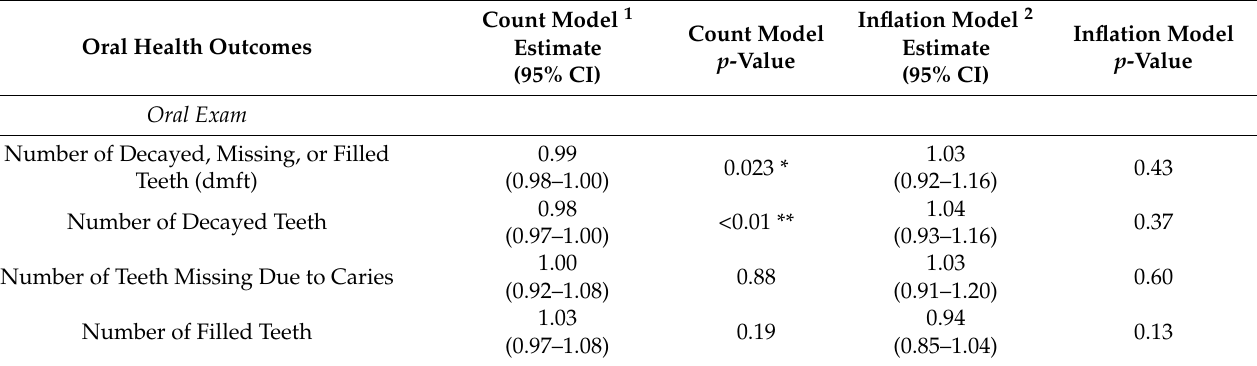
Table 5. Zero-Inflated Poisson Model: Relationship between Years of Maternal Education and Child Oral Health